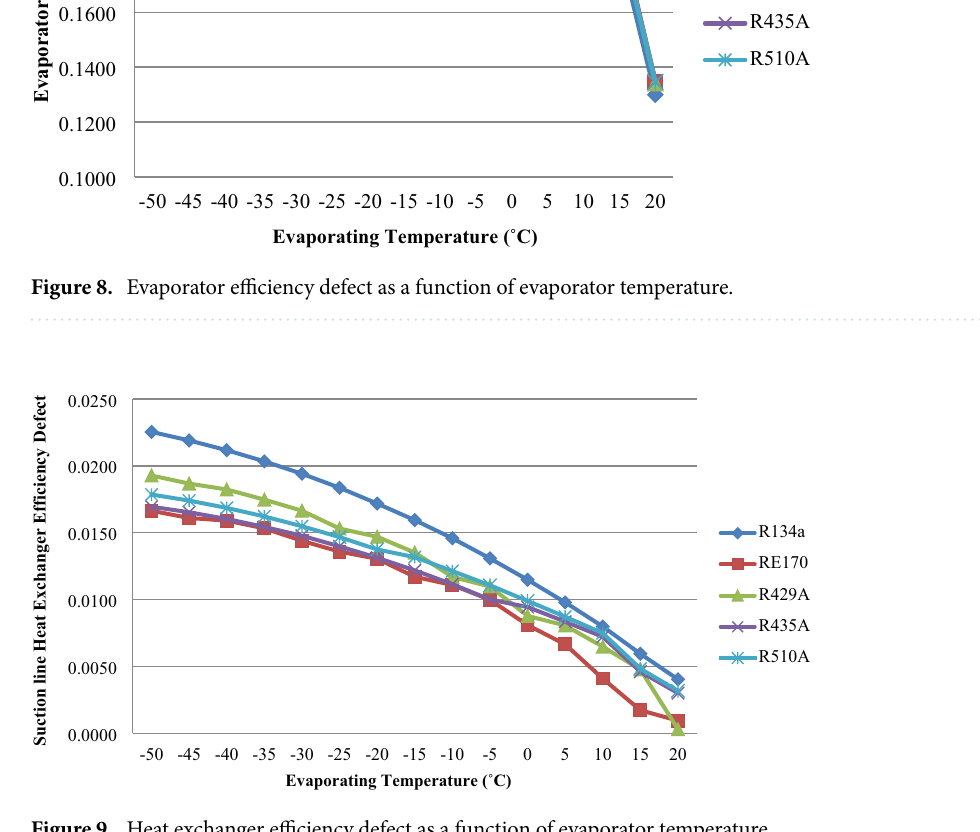
Figure 9. Heat exchanger efficiency defect as a function of evaporator